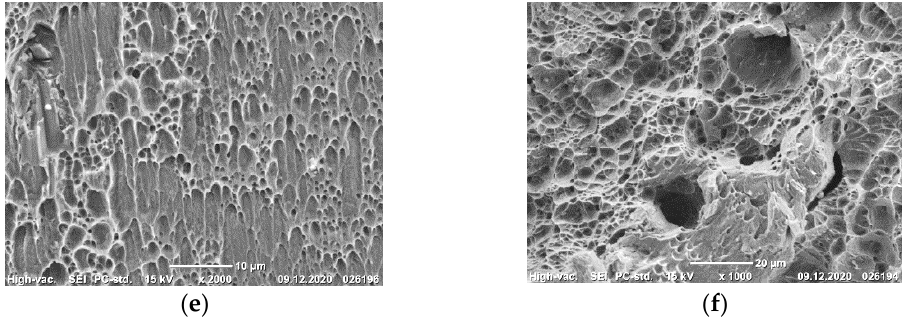
Figure 5. Torsional fracture surface microrelief of the specimens from the CG ( a – c ) and UFG ( d – f ) steel. The microrelief was taken from the peripheral ( a , d ), middle ( b , e ), and central ( c , f ) parts of the fracture surface. ( a,b,c,f )—×1000; ( d,e )—×2000.